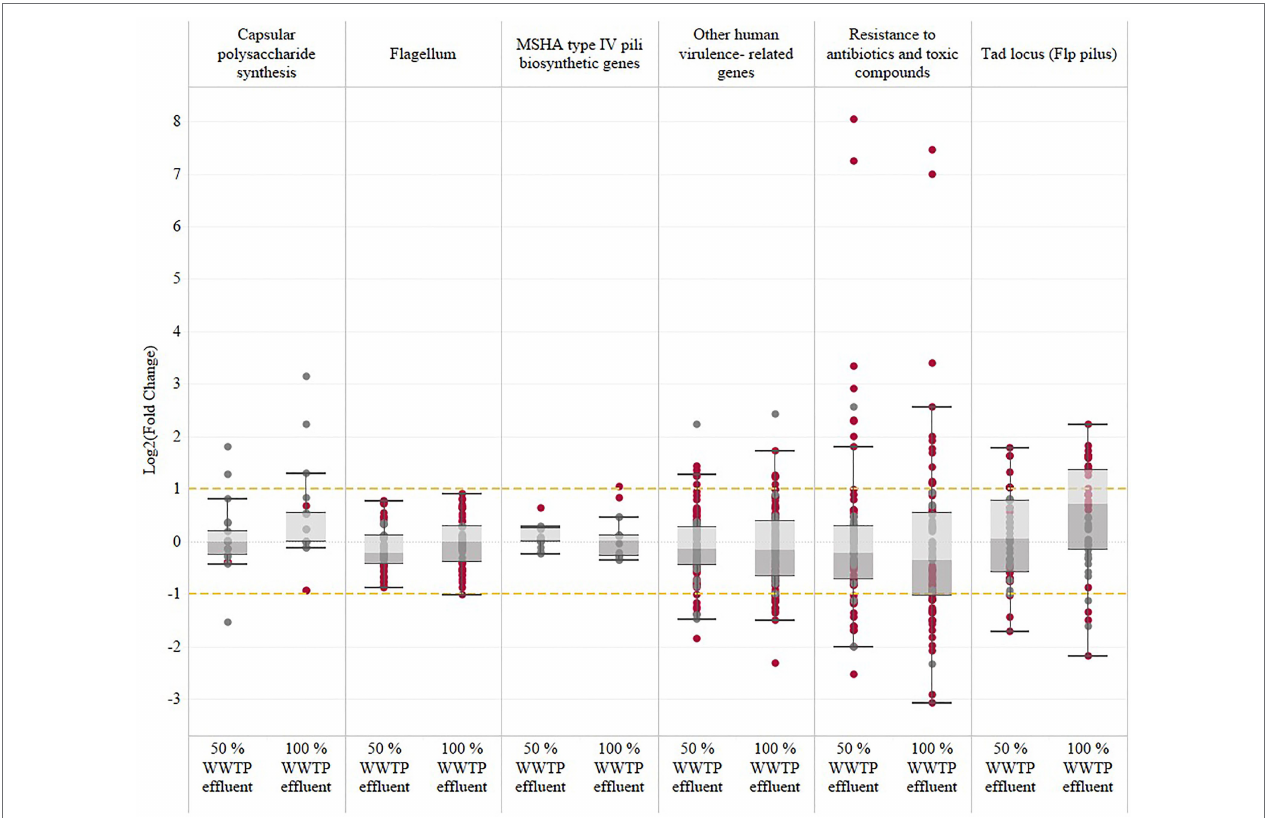
FIGURE 2 | Vibrio vulnificus expression of human-virulence-related genes in response to wastewater effluent exposure. The human-virulence genes documented in this study and in previous studies (Williams et al., 2014; Roig et al., 2018) have been identified and categorized into six subcategories based on the most relevant virulence factors: capsular polysaccharide synthesis, flagellum, MSHA type IV pili biosynthetic genes, resistance to antibiotics and toxic compounds, and other human-virulence-related genes. The significantly regulated genes (FDR-adjusted value of p ≤ 0.05) are represented with garnet dots, and gray dots represent the non-significant